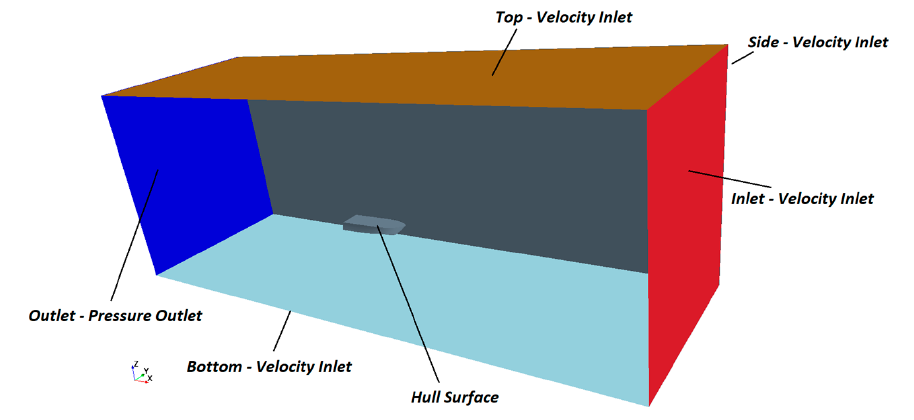
Figure 5. Boundary conditions.